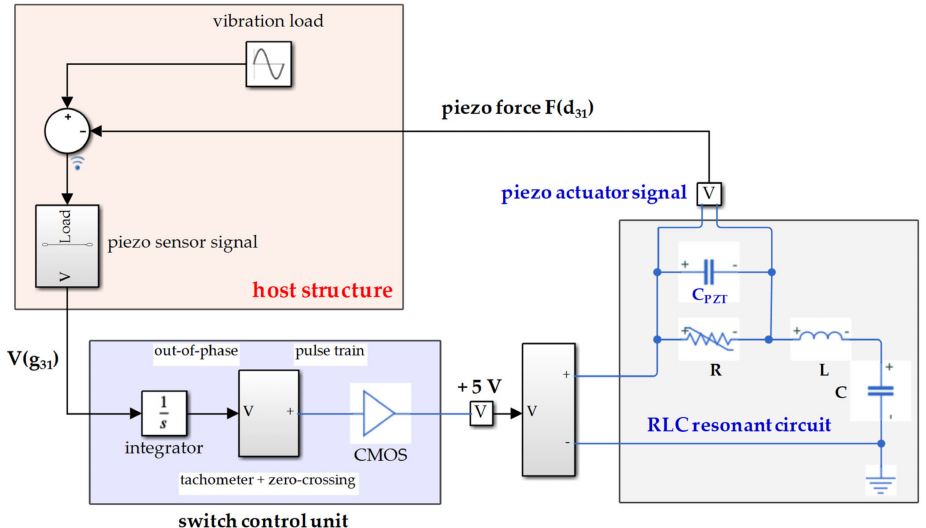
Figure 10. Control board